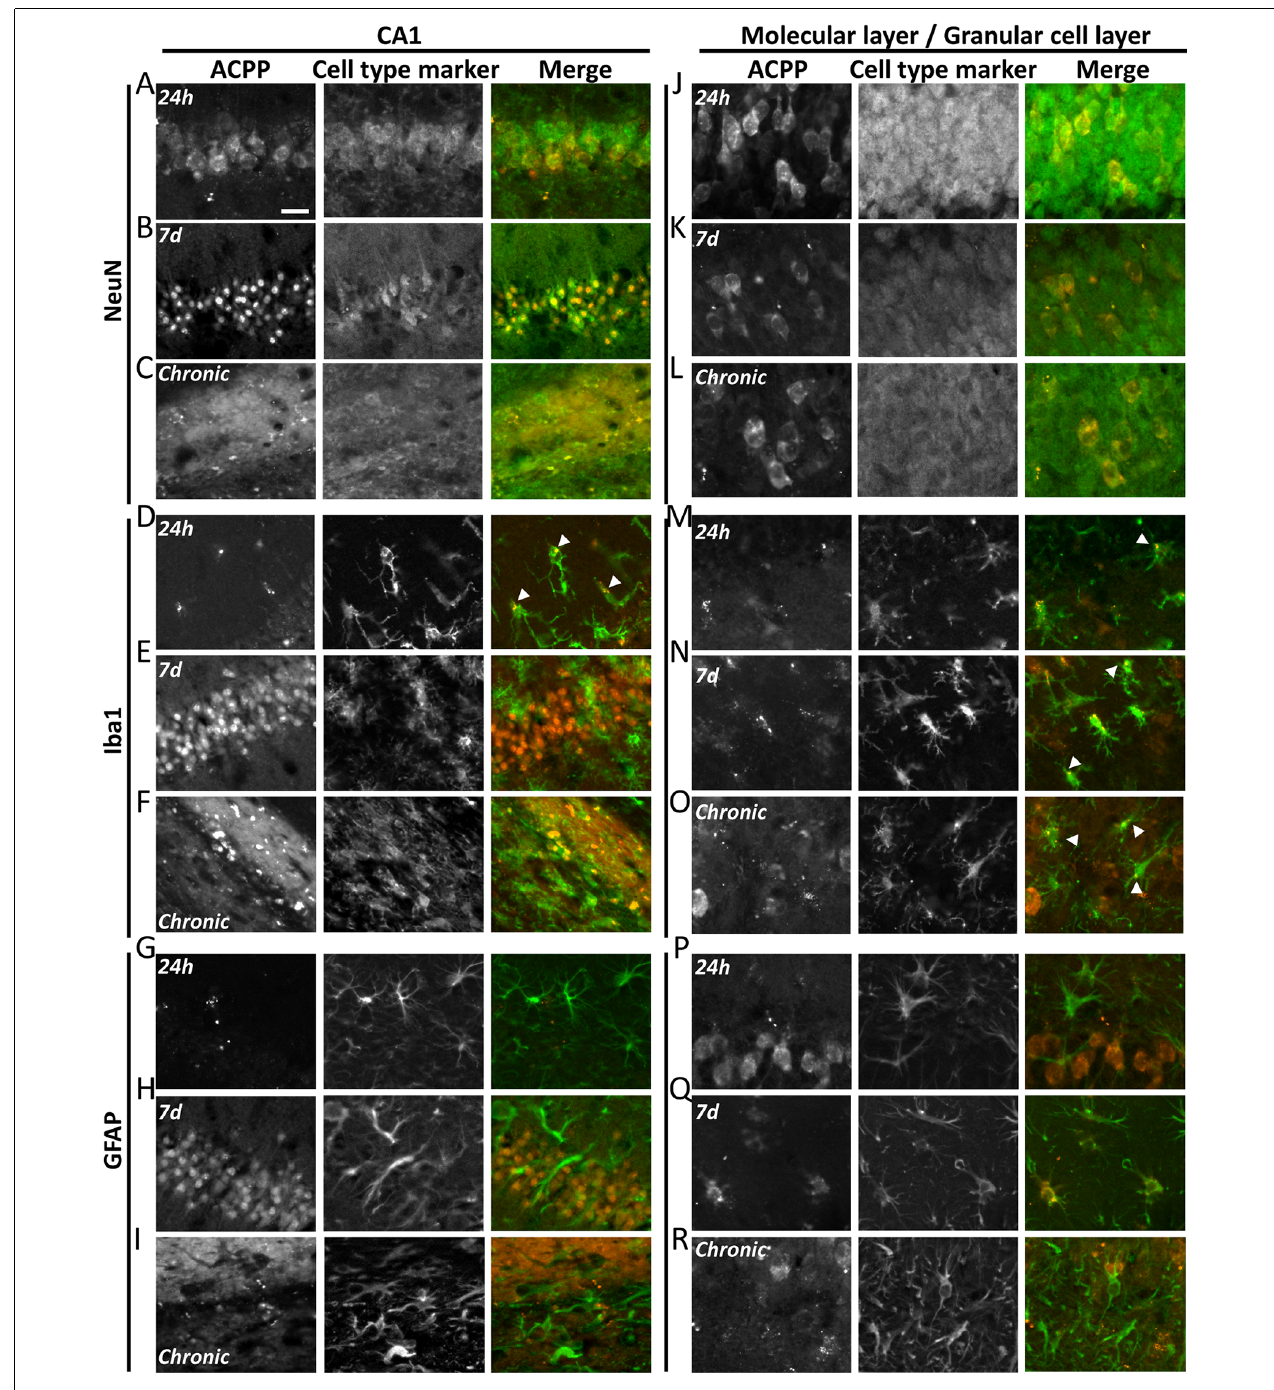
FIGURE 6 | ACPPs reveal cell-type-specific kinetics of gelatinase activity during epileptogenesis. The gelatinase spatiotemporal activation profile was observed with gelatinase-ACPP uptake in CA1 and molecular and granular layers of KA-injected hippocampi at 24 h, 7 days after KA injection or during the chronic phase. Slices were stained with neurons marker NeuN (A–C,J–L ), microglial marker Iba1 (D–F,M–O ) or astrocytic marker GFAP (G–I,P–R ). Merge of the cell type marker (green) and TAMRA ACPP (orange) are shown. n = 3 independent experiments, two or three animals injected per condition for each experiment, three slices per mouse were used. Scale bar 20 µ